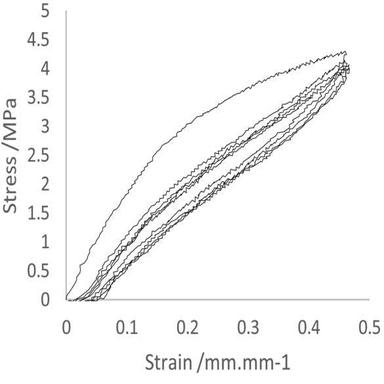
cyclic behaviour of NinjaFlex under uniaxial loading.